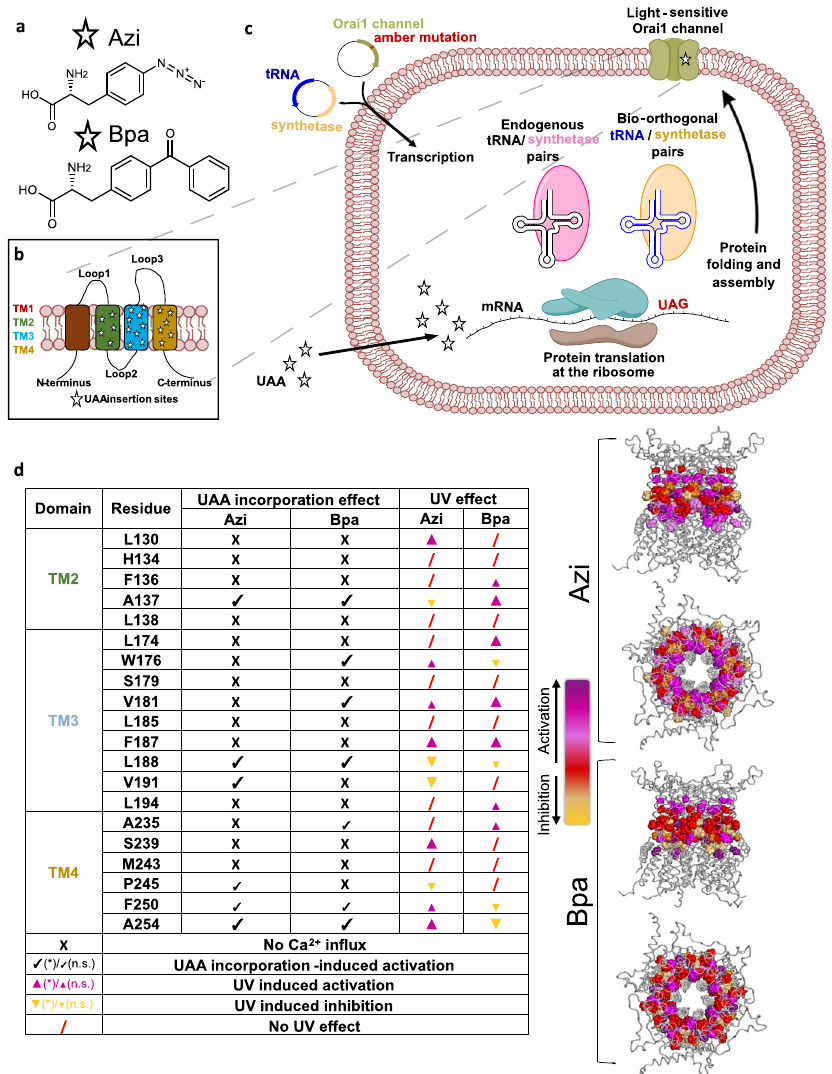
Fig. 1 | Site-speci fi c incorporationofAzi and BpainOrai1. a Chemicalstructures ofAziandBpa. b SchemeoftheTMdomainsofanOrai1subunit.Starsindicatesites forUAAincorporation. c PrincipleofUAAincorporationinmammaliancells.Agene encoding a protein of interest (here Orai1) containing an Amber stop codon (TAG) inserted at the desired site is co-transfected with a bioorthogonal tRNA (blue)/ aminoacyl synthetase (RS) pair (yellow) that does not crosstalk with endogenous pairs(black/pink).Cellsareincubated withthe UAAsupplementedinthemedium. Within the host cell, the suppressor tRNA, aminoacylated with the UAA by the bioorthogonal RS, recognizes the Amber stop codon on the mRNA (UAG codon, red)atthe ribosometo insertthe UAA intothenascentamino acidchain. Different light-sensitiveOrai1mutantsaregenerated carryingthephotocrosslinkingUAAsat the desired sites. d The table summarizes the effects on Ca 2+ in fl ux of all screened Orai1mutantscontainingAziorBpaatapositioninTM2-4afterUAAincorporation and after UV light (365nm) irradiation. A cross indicates no activity (below